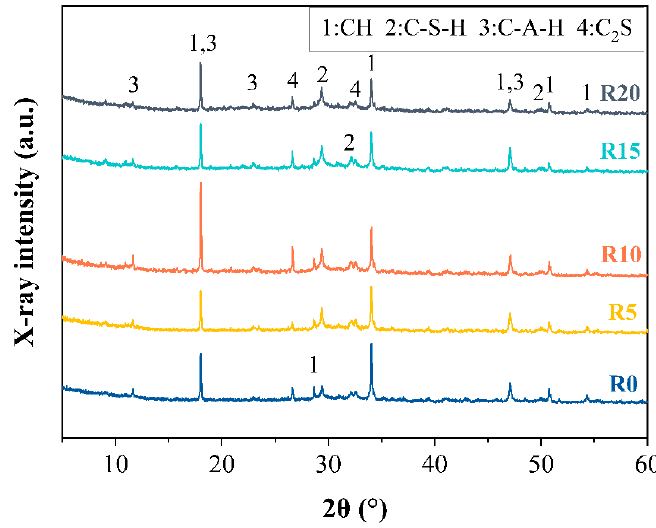
Figure 7. XRD patterns of 28-day pastes.